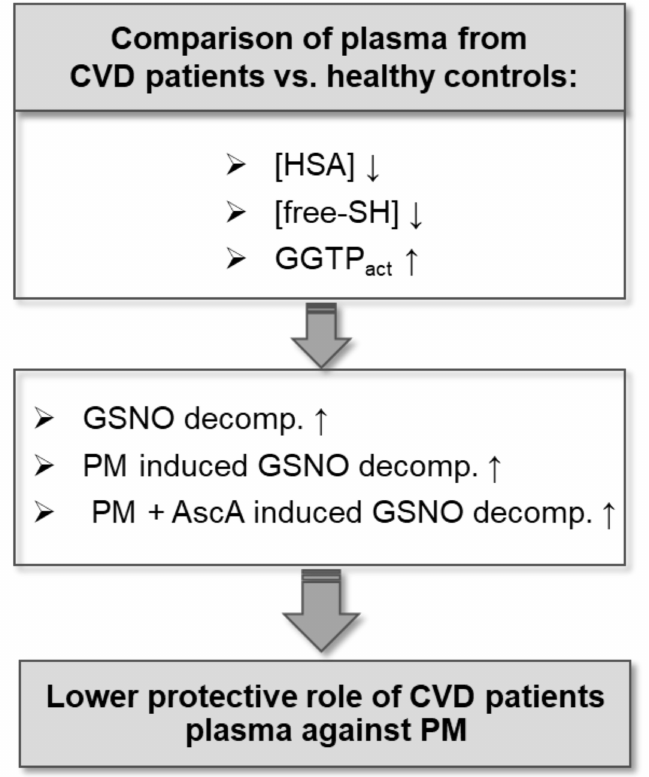
Figure 6. Schematic representation of the major outcomes. Plasma from cardiovascular diseases (CVD) patients compared to healthy control is characterized by the decreased concentration of human serum albumin (HSA), lowered availability of free thiol groups (SH), and increased activity of gamma- glutamyltransferase (GGTP). These differences may be responsible for increased decomposition of S-nitrosoglutathione (GSNO), particularly under the influence of particulate matter (PM) and the supplementation with ascorbic acid